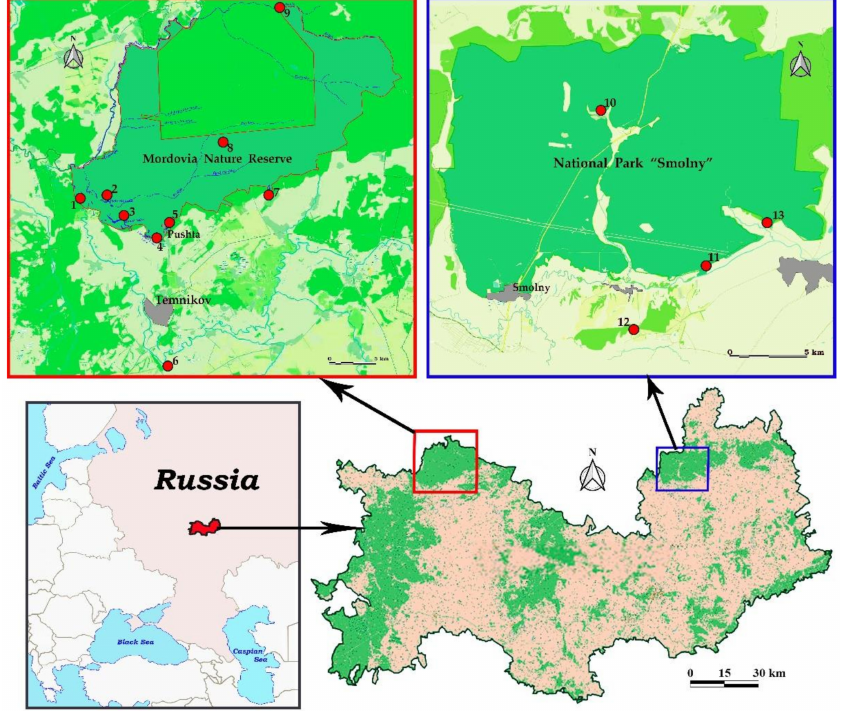
Figure 1. A map of land birds’ trapping places in the Republic of Mordovia (European Russia). Red circles in the map show the bird trapping sites. 1—Taratinskiy cordon, 2—Inorki Lake, 3—